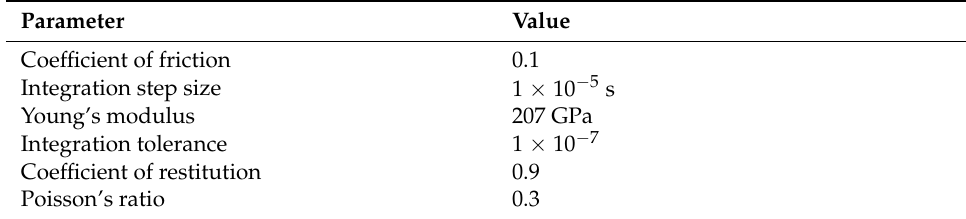
Table 3. Dynamic simulation parameters of the assembly robot.